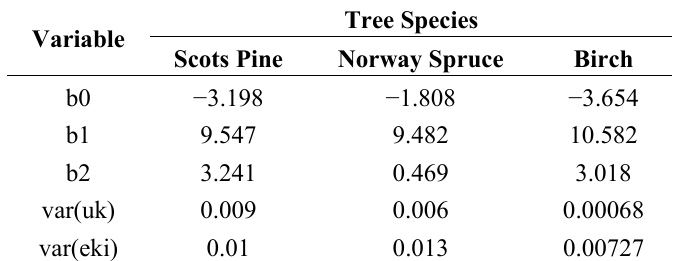
Table 1. Parameters for aboveground biomass for models 1–3 by Repola [41,42].